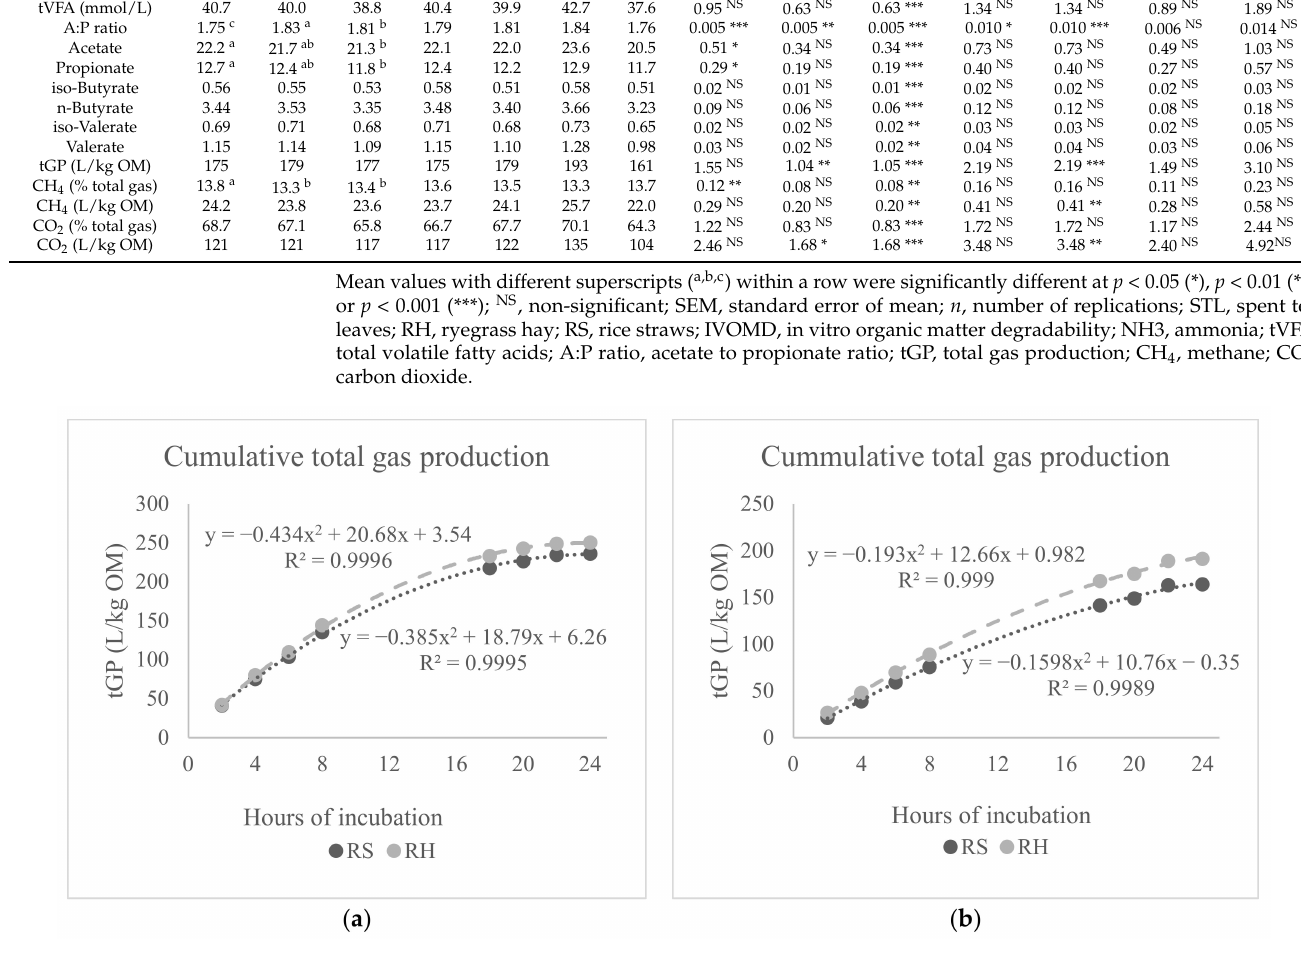
Figure 3. Cumulative total gas production (tGP, L/kg OM) of tea leaves ( a ) and spent tea leaves (STL, ( b )) in either ryegrass hay (RH, grey) or rice straw (RS, black) based diets during rumen in vitro incubation up to 24